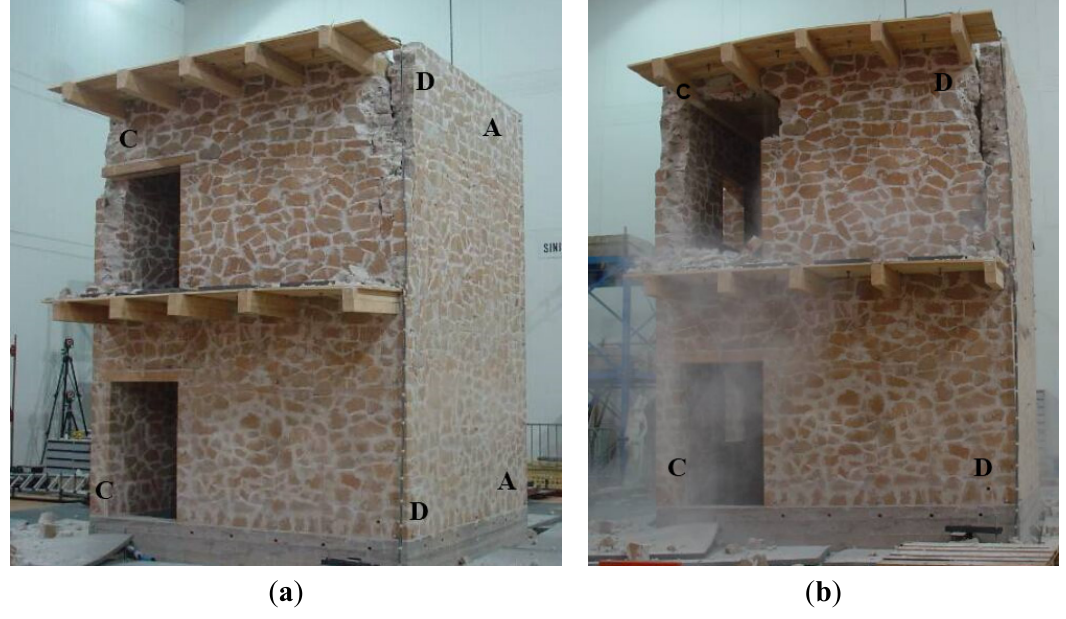
Figure 7. Façade CD cracks after failures of the corners of the second level (( a ) PGA = 0.35 g) and failure of the lintels (( b ) PGA = 0.45